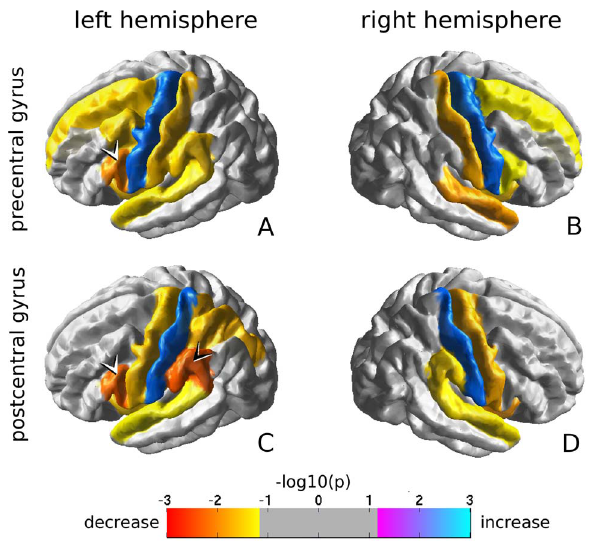
Figure 2. Abnormalities in rolandic connectivit. Only reductions in tract FA were found for patients compared to controls, the most extensive and significant of which were located in the left hemisphere. Especially notice the FA reduction for the rolandic connections with the pars opercularis of the inferior frontal gyrus (white arrowheads in A and C), and the postcentral connection with the supramarginal gyrus (black